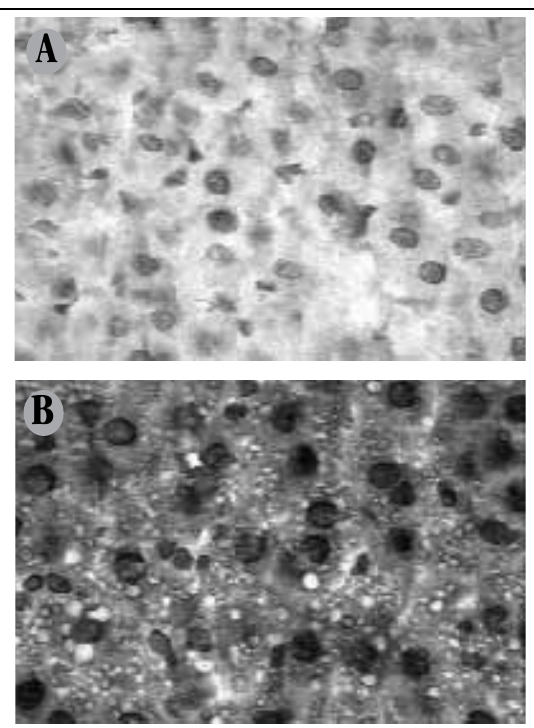
figurE 5 – Pattern of cytoplasmic immunostaining for liver TNF- α A) in the control group (25×); B) intense and diffuse cell staining associated to steatosis in the group on the high-fat diet (25×). TNF- α : tumor necrosis factor alpha.